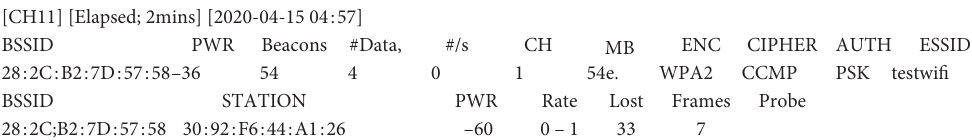
Figure 5: Target AP